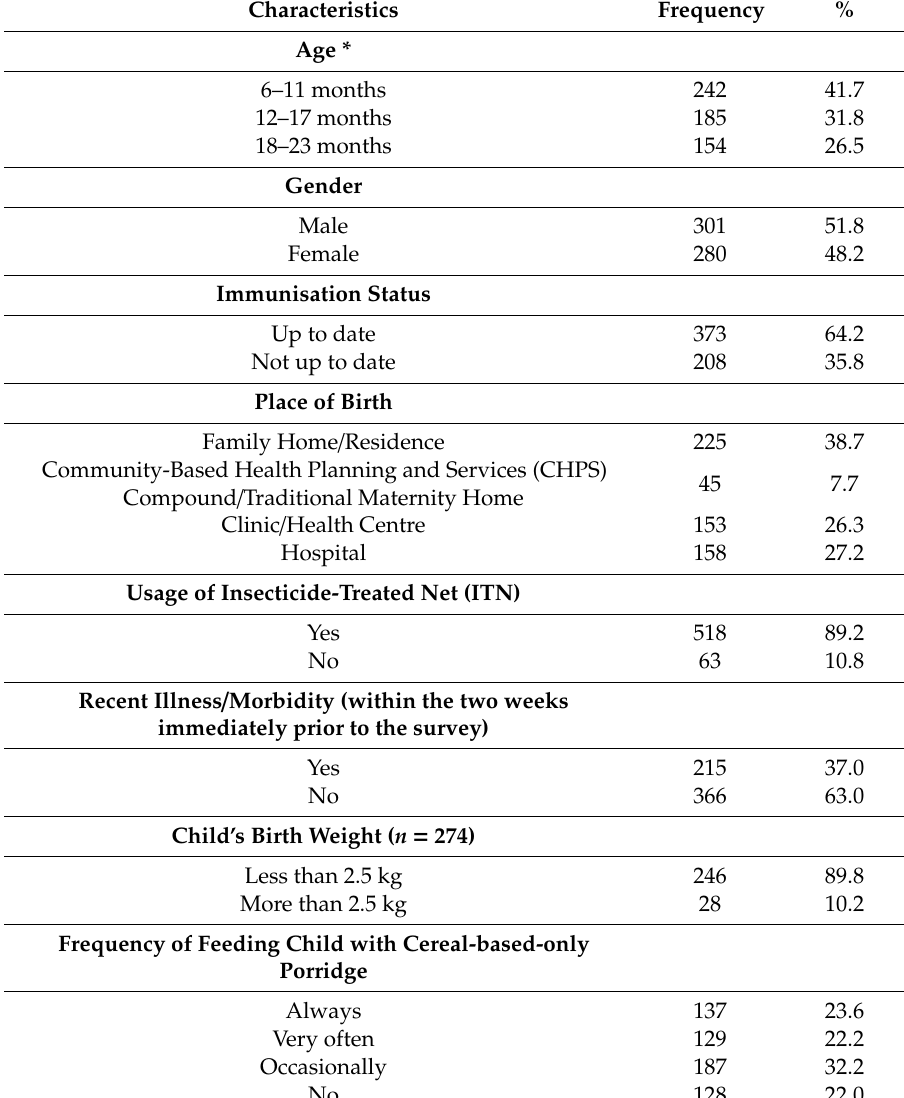
Table 2. Child Characteristics ( n =